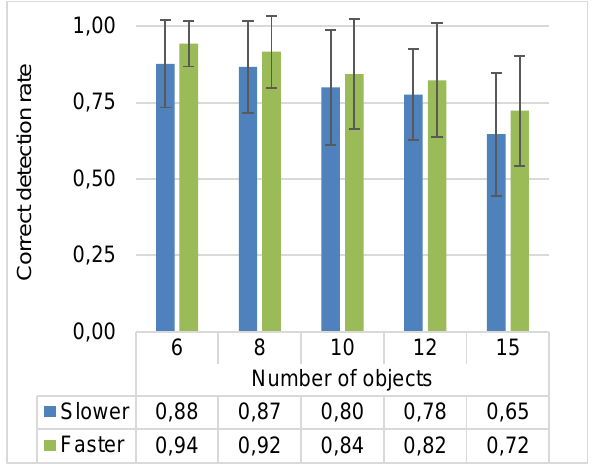
Figure 8: Mean of correct detection rate.